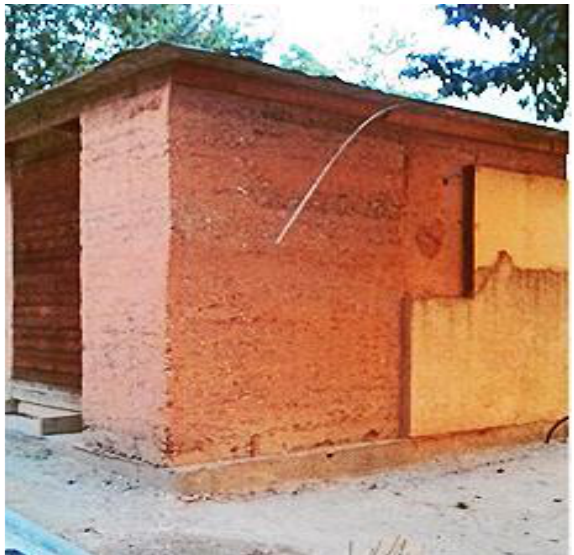
Figure 3. Earth-wood, low embodied energy. Photo: César Arguedas.